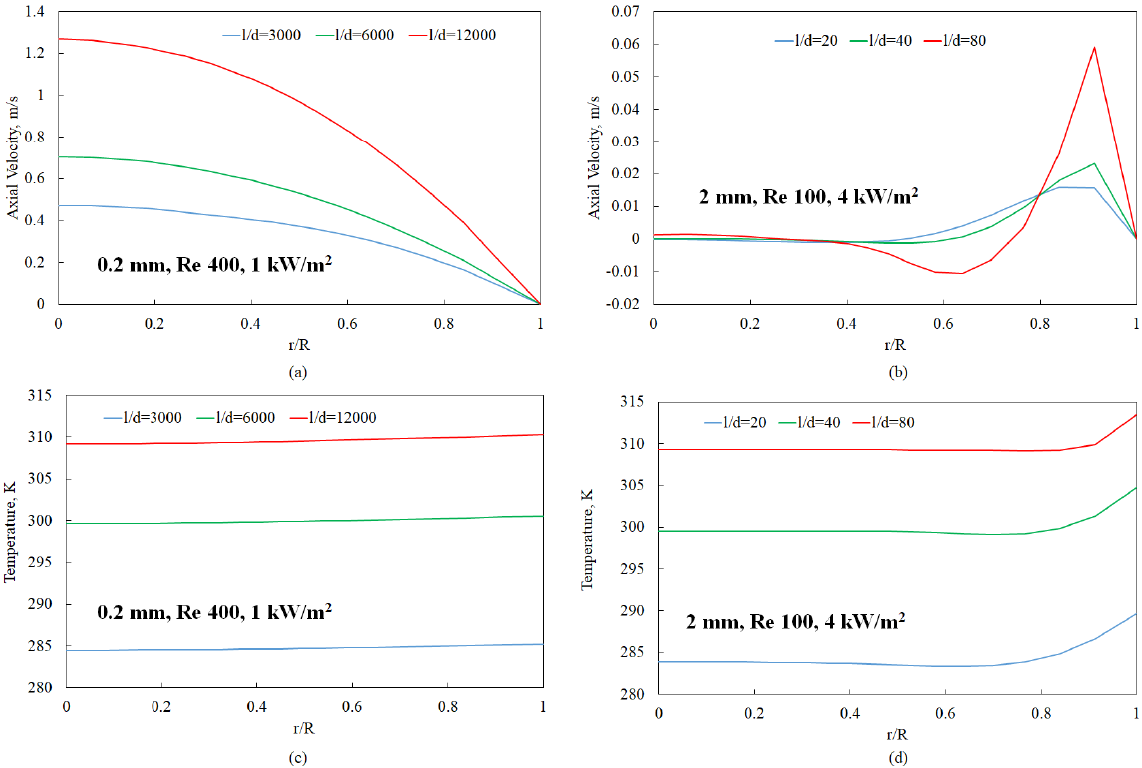
Figure 7. Axial velocity and temperature profiles at different axial locations (indicated by distances from the inlet (l) over diameter (d) ratios). The radial locations are specified as the distance from the tube center (r) over the tube diameter (R): ( a ) 0.2 mm diameter tube, axial velocity; ( b ) 2 mm diameter tube, axial velocity; ( c ) 0.2 mm diameter tube, temperature; ( d ) 2 mm diameter tube, temperature.